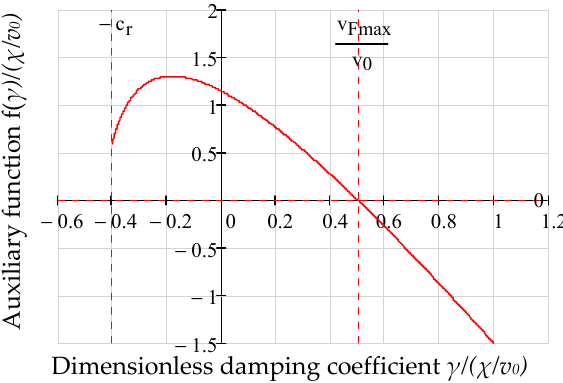
Figure 4. Obtaining the value of the velocity, v Fmx , corresponding to maximum force. The approach 𝑥 (cid:3007)(cid:3040)(cid:3051) corresponding to this velocity is calculated with the following